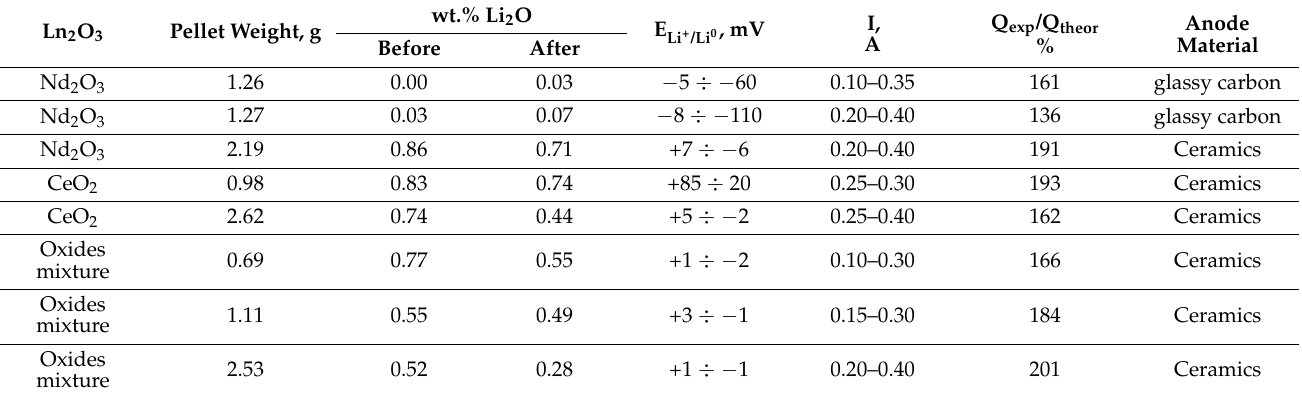
Table 1. Parameters and regimes of the REM oxides electrolysis.